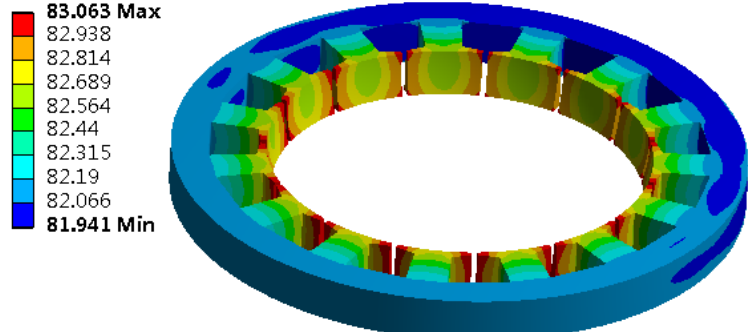
Figure 10. Contour diagram of stator core temperature.